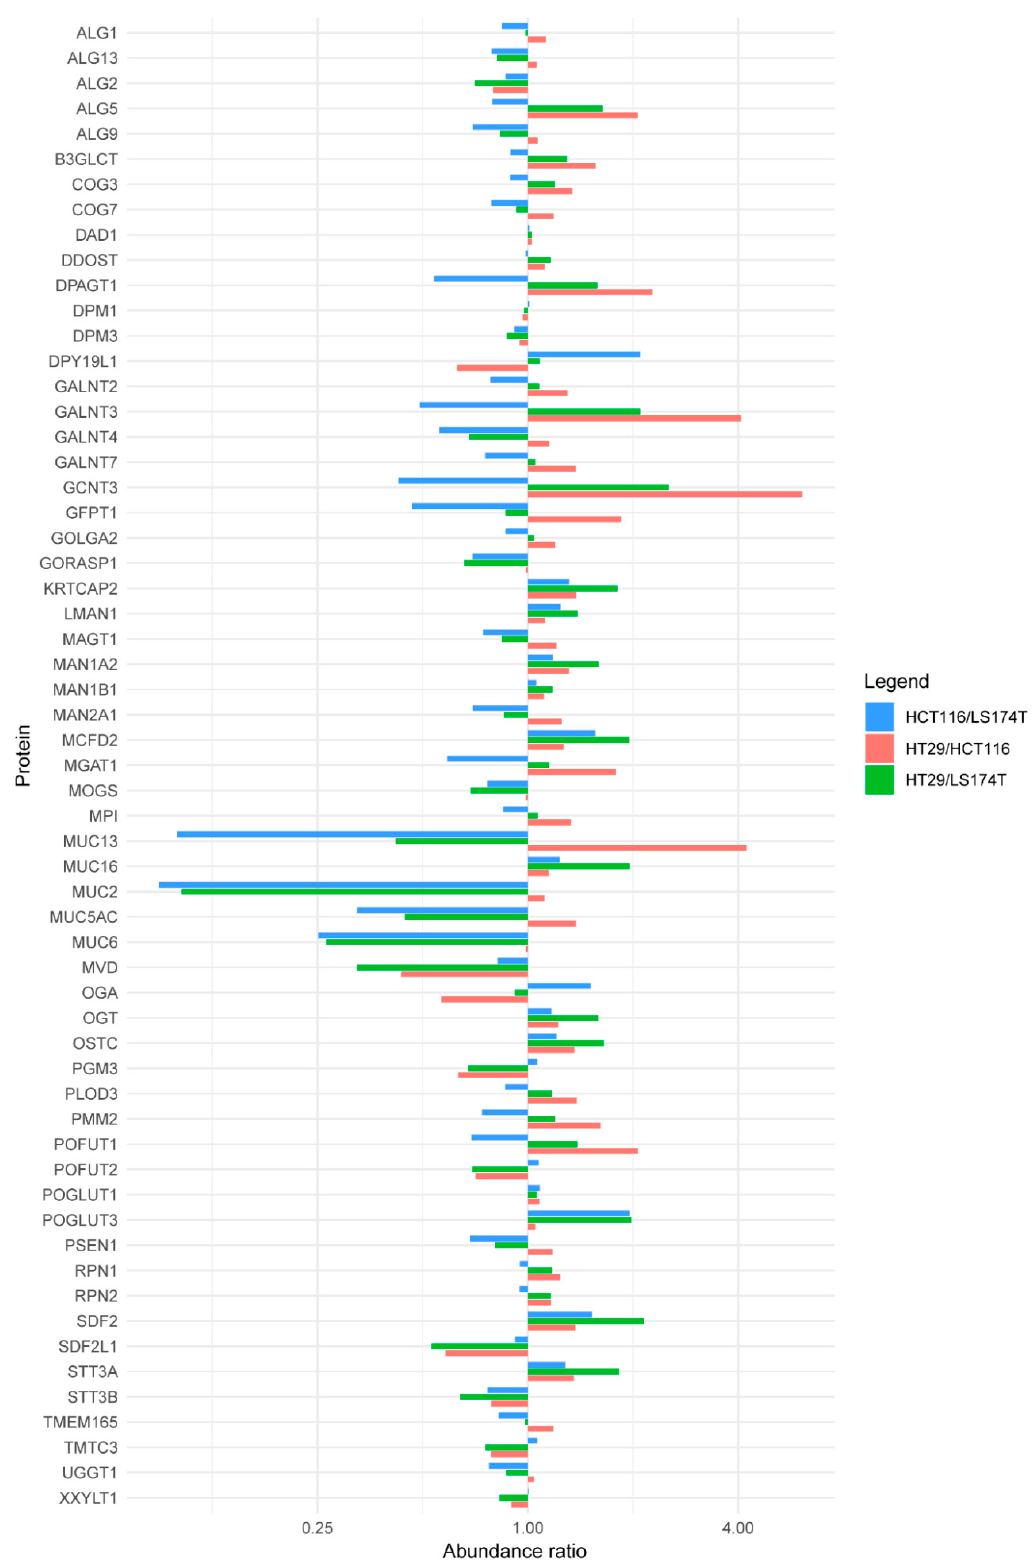
Figure 3. Quantitative proteomics analysis of proteins involved in glycosylation in CRC cell lines. The y-axis shows proteins involved in the glycosylation machinery covered in our study. The x-axis shows the ratio of protein abundance in HCT116 versus LS174T (blue), HT29 versus HCT116 (pink) and HT29 versus LS174T (green).